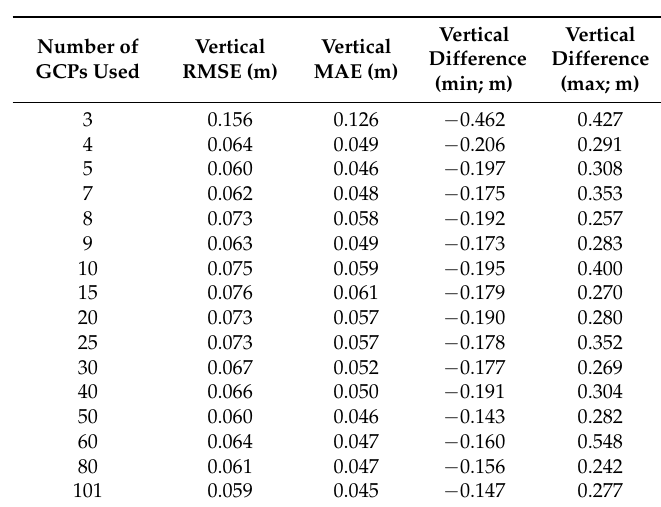
Table 1. Digital surface model (DSM) quality in relation to the random placement of ground